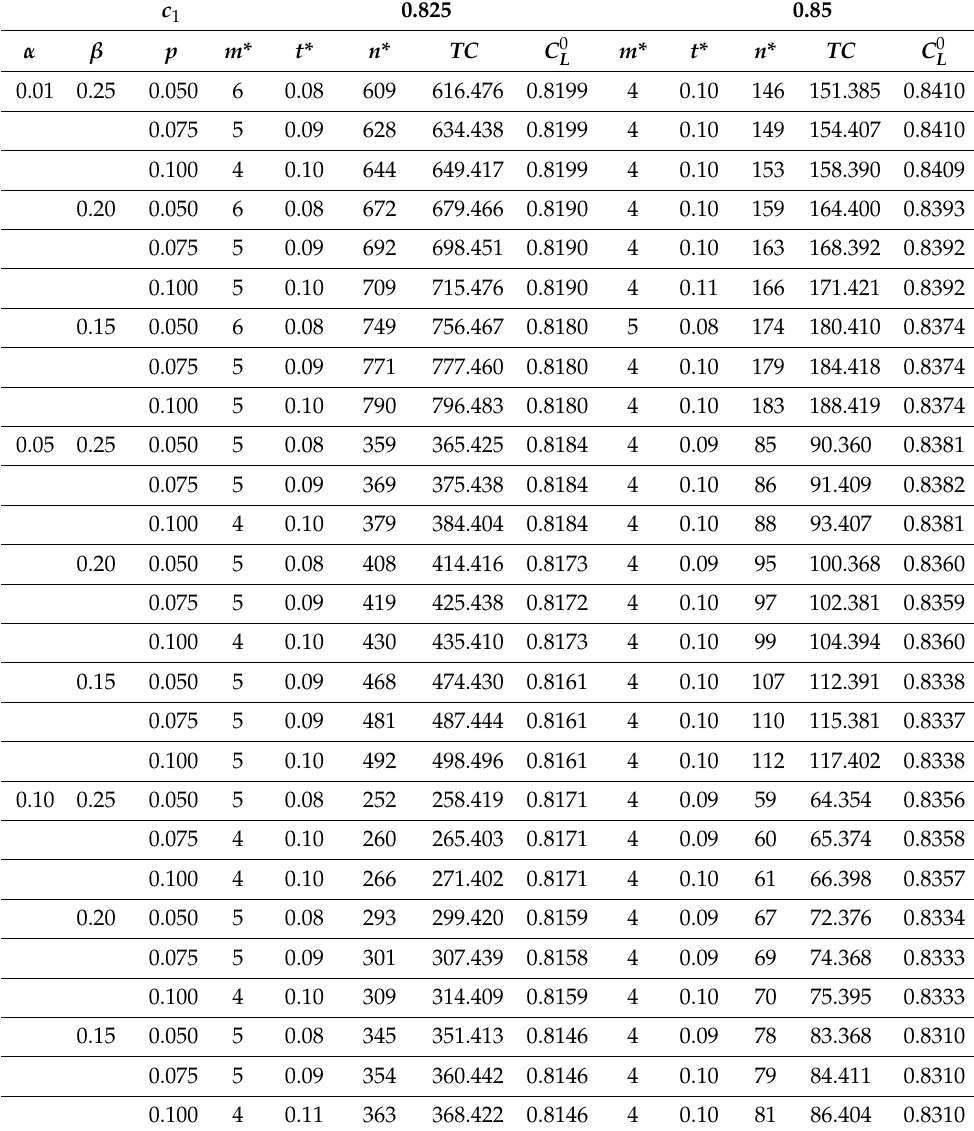
for c 1 = 0.825, 0.85 L